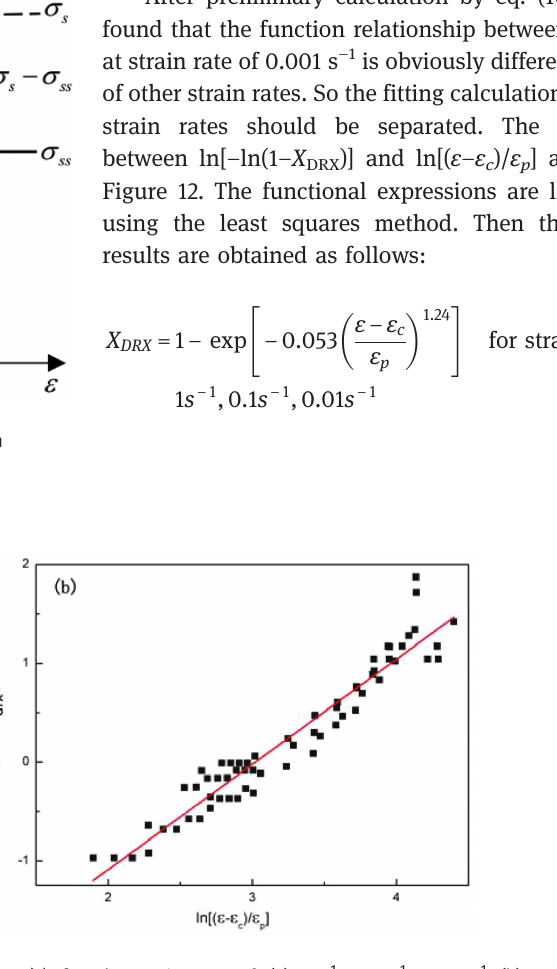
Figure 12: The relationship between ln[-1n(1 – X drx )] and ln[( ε – ε c )/ ε p ] under strain rates of: (a) 1 s – 1 ; 0.1 s – 1 ; 0.01 s – 1 ; (b) 0.001 s – 1 .